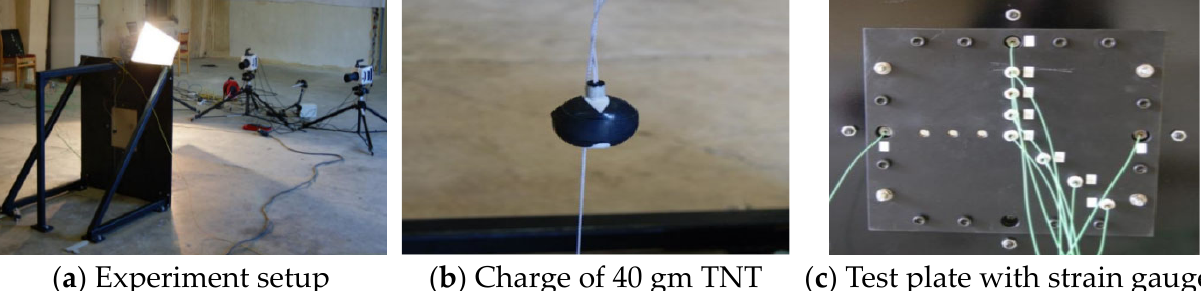
( b ) Charge of 40 gm TNT ( c ) Test plate with strain gauges Figure 8. Field experiment [38]. Figure 8. Field experiment [38]. ( c ) Test plate with strain gauges The steel plate was simulated in AUTODYN with the same characteristics as that used in the experiment. The boundary conditions assigned to the plate were the same as the real Figure 8. Field experiment [38]. experiment boundaries. The domain was simulated as an air cube around the plate with flow-out boundaries, which allowed the shockwave to propagate away and prevent its reflection. Figure 9 illustrates the simulated steel plate and the domain with the remapped TNT